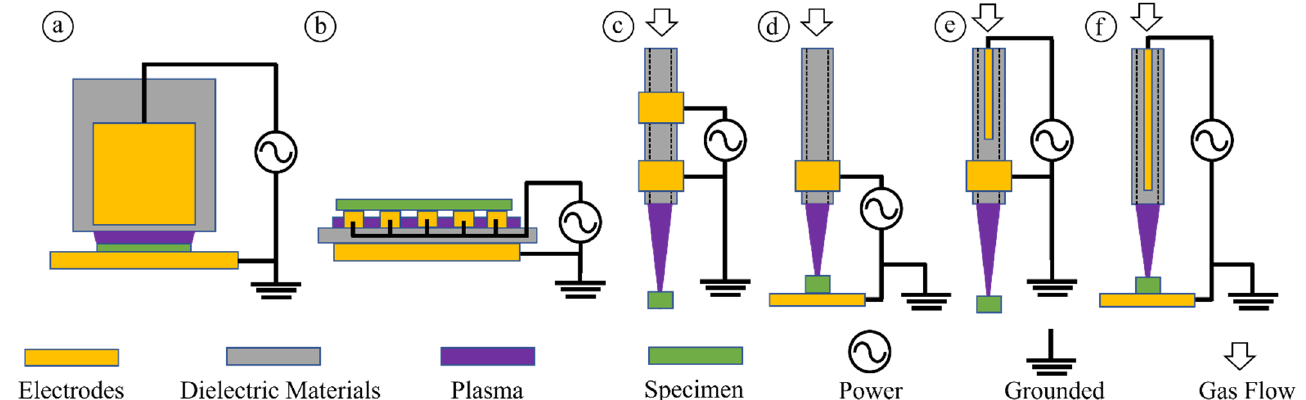
Figure 1. Typical CAP sources used in plasma medicine. Type a. Volume DBD. Type b. Surface DBD. Type c. Two-ring electrodes APPJ. Type d. Plasma torch using ring electrode. Type e. One central electrode-one ring electrode APPJ. Type f. Plasma torch using a central electrode.